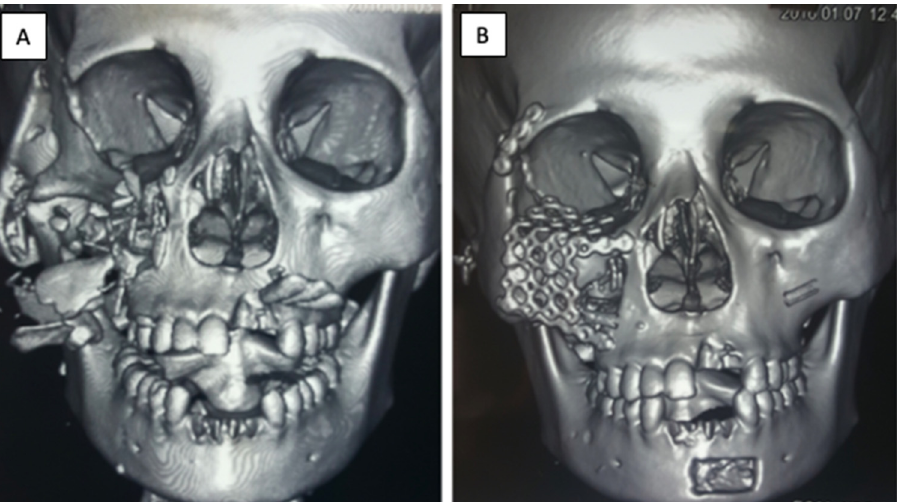
Fig. 1. (A) Comminution of the lateral wall of the orbit, body of Zygoma and Zygomaticomaxillary buttress along with orbital fl oor fracture. (B) Accurately shaped and moulded Zygomaticomaxillary complex and orbital fl oor with a single spanning Titanium Mesh with Mandibular symphysis bone graft used at the zygomaticomaxillary